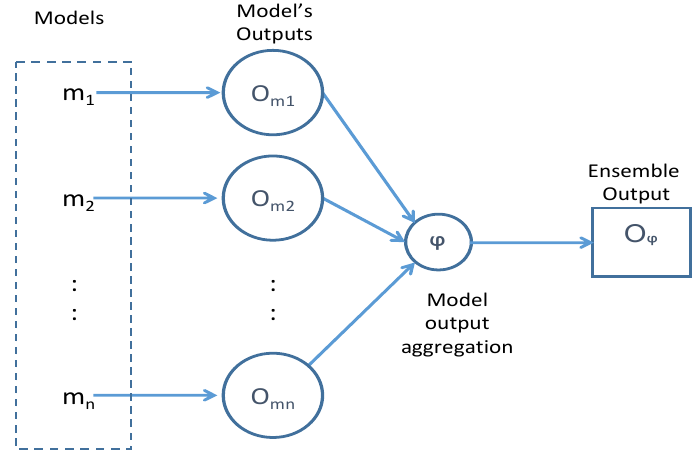
Figure 3. Summary of the aggregate ensemble method.